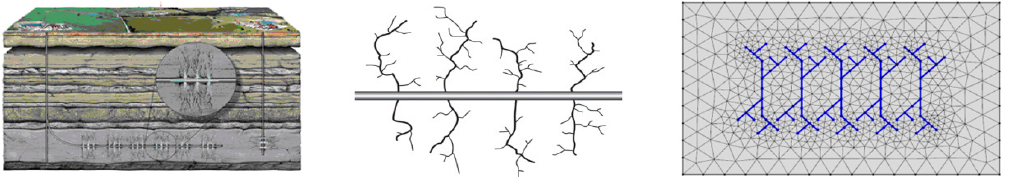
Figure 9. DFN model mesh of a fracture network system in shale.